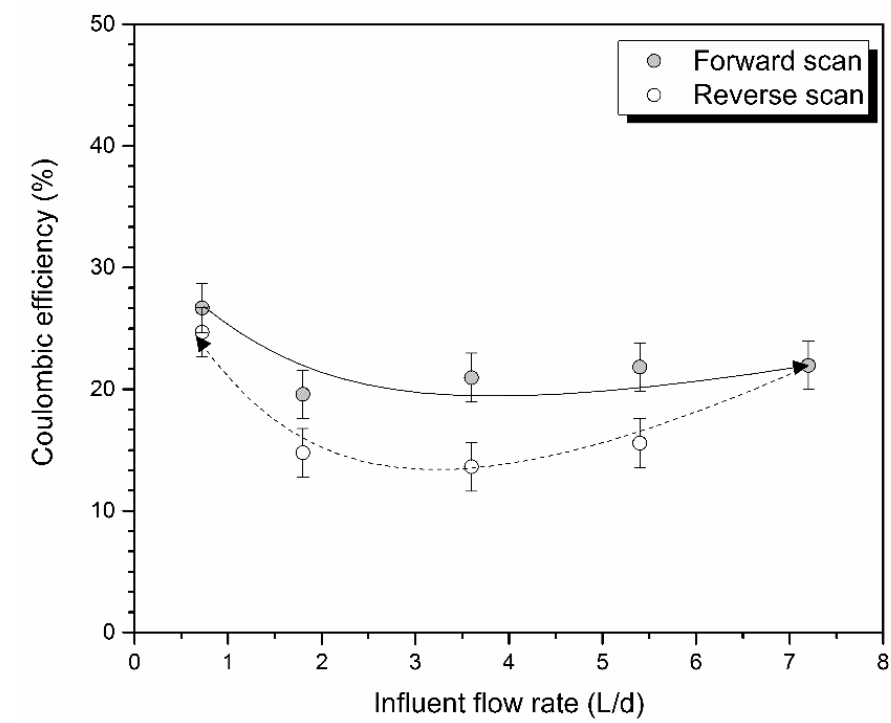
Figure 4. Dependence of Coulombic efficiency (CE) with the influent flow rate.